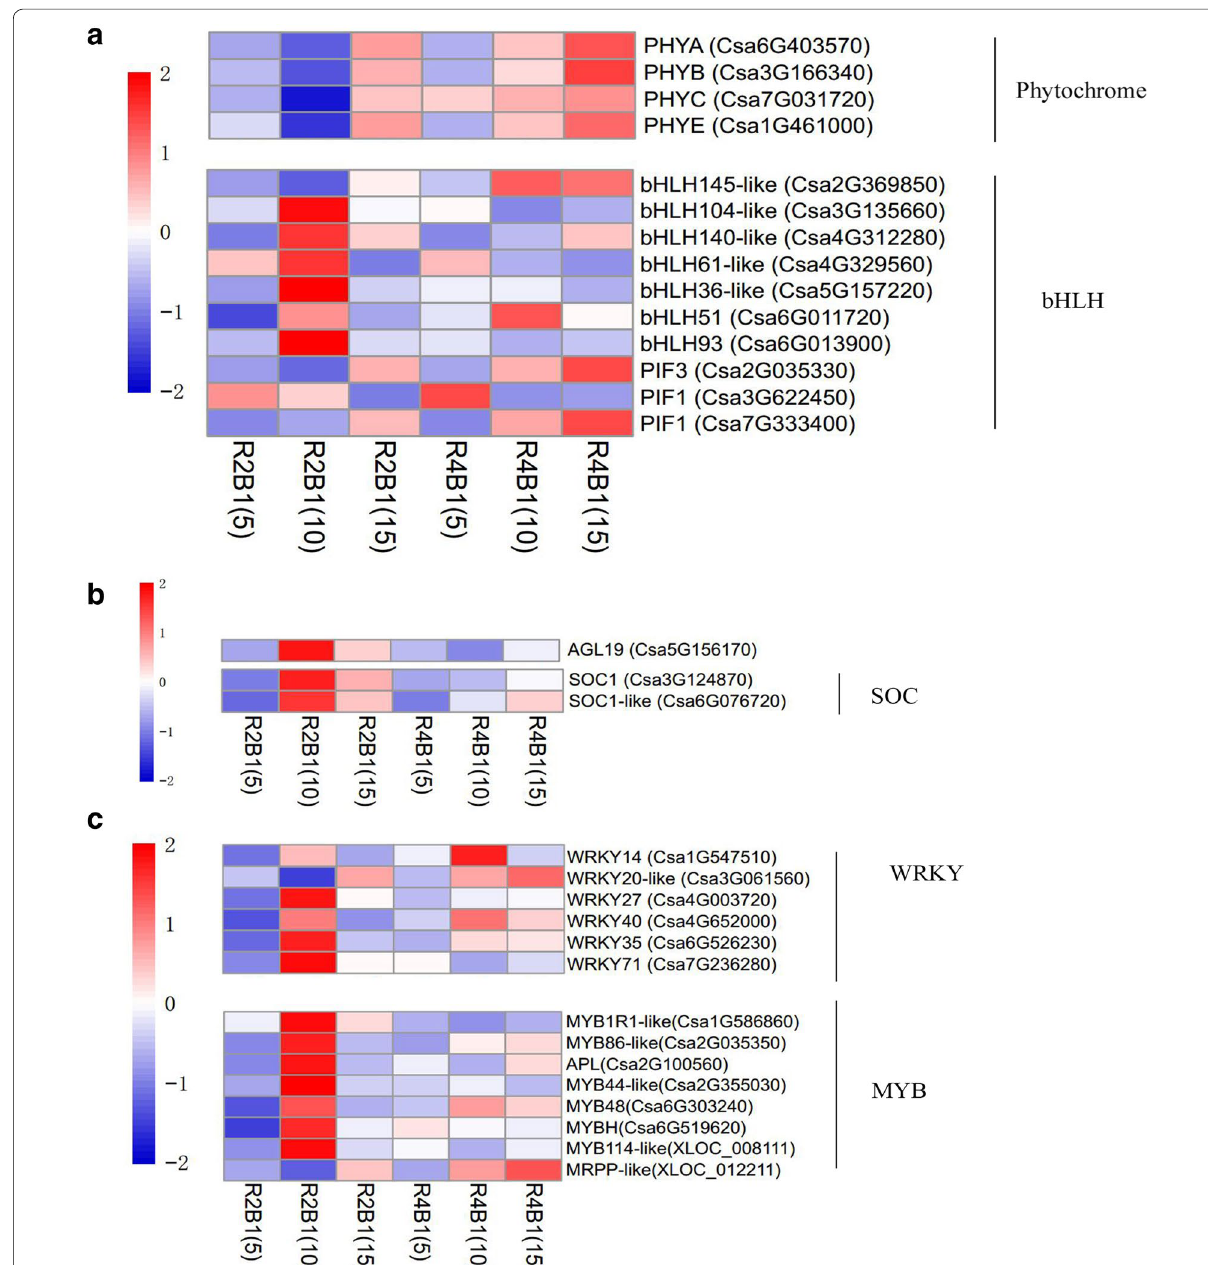
Fig. 8 The expression of a number of genes altered in cucumber shoot apices under different light quality treatments: a genes involved in light signaling transduction; b genes related to flowering time regulation and c transcription factors involved in plant hormone and flower organ